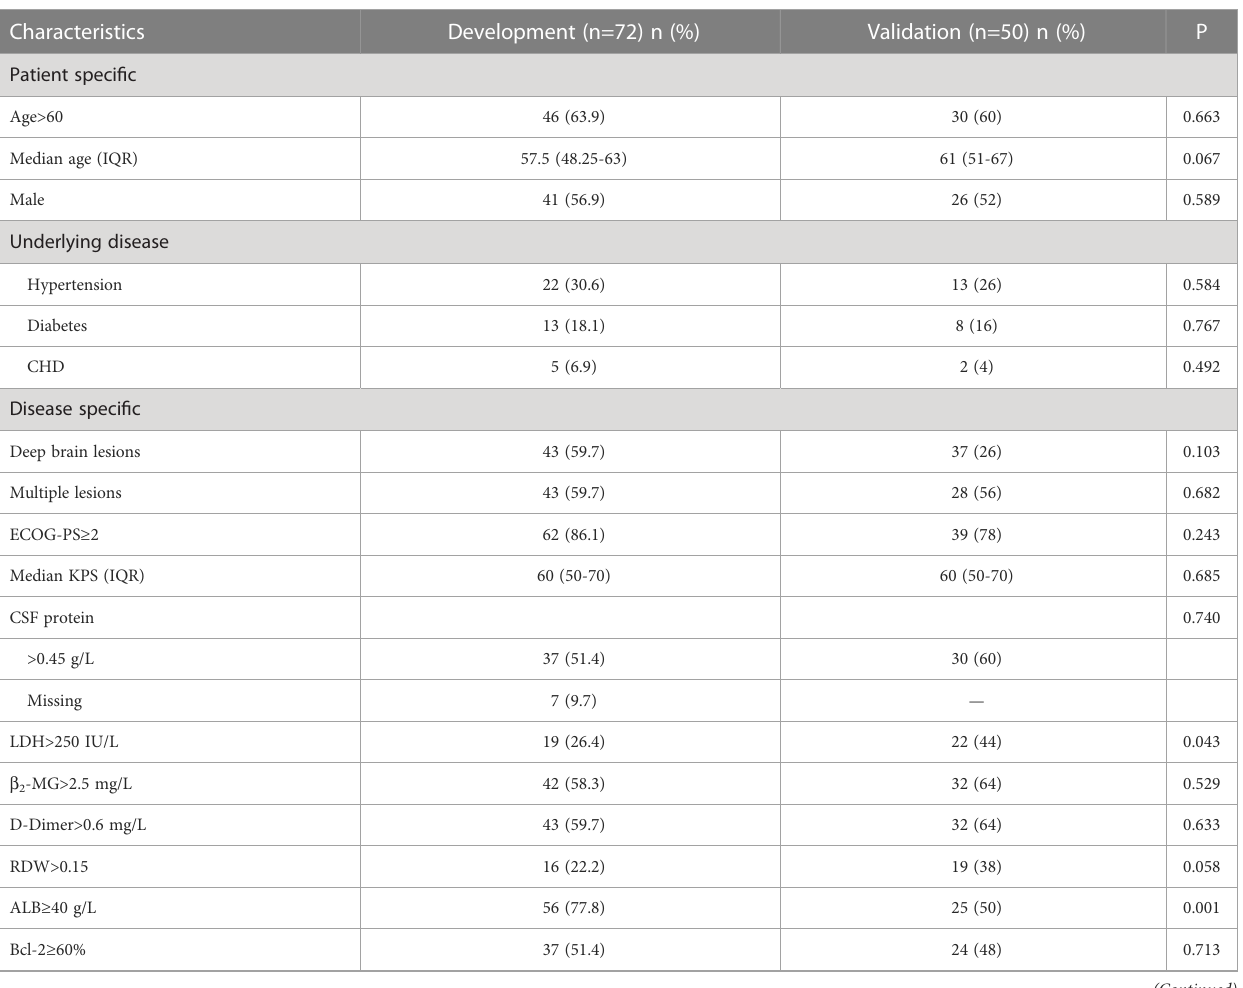
TABLE 1 Baseline characteristics of development and validation